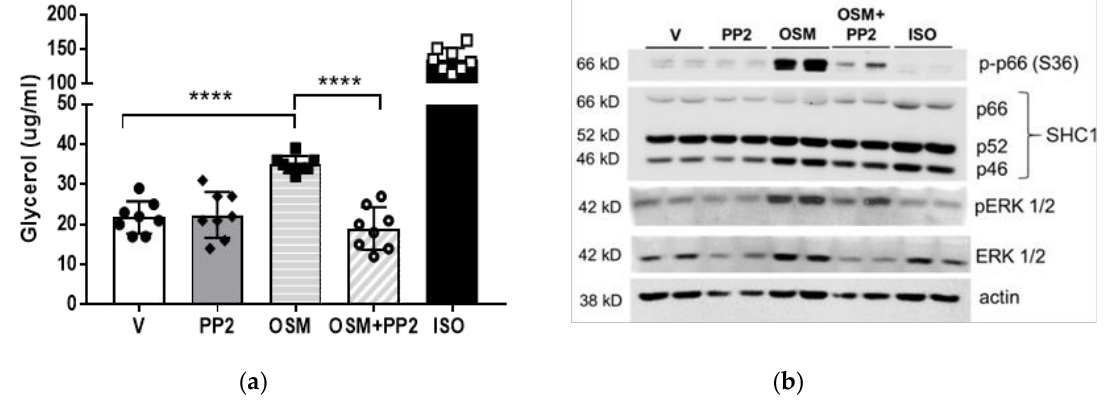
Figure 4. Pharmacological inhibition of SHC1 abrogates OSM-stimulated adipocyte lipolysis. ( a ) Fully differentiated 3T3-L1 adipocytes were pretreated with the SHC1 inhibitor, PP2 (10 μ M), in a regular maintenance medium the night before the assay. On the day of the assay, adipocytes were placed into an incubation medium containing V, the SHC1 inhibitor PP2 (10 μ M), 0.5 nM OSM, OSM + PP2, or 10 μ M ISO as a positive control, for 4 h. Glycerol measurements were obtained from 50 μL media (n = 7 – 8 wells per condition). PP2 alone did not affect basal lipolysis, but completely inhibited the OSM induction of lipolysis. ( b ) Immunoblotting of cell lysates from ( a ) was used to verify SHC1 inhibition using p66Shc and ERK phosphorylation as readouts. This experiment was conducted twice on independent batches of adipocytes. Significant differences are denoted as follows: **** p < 0.0001 between groups.